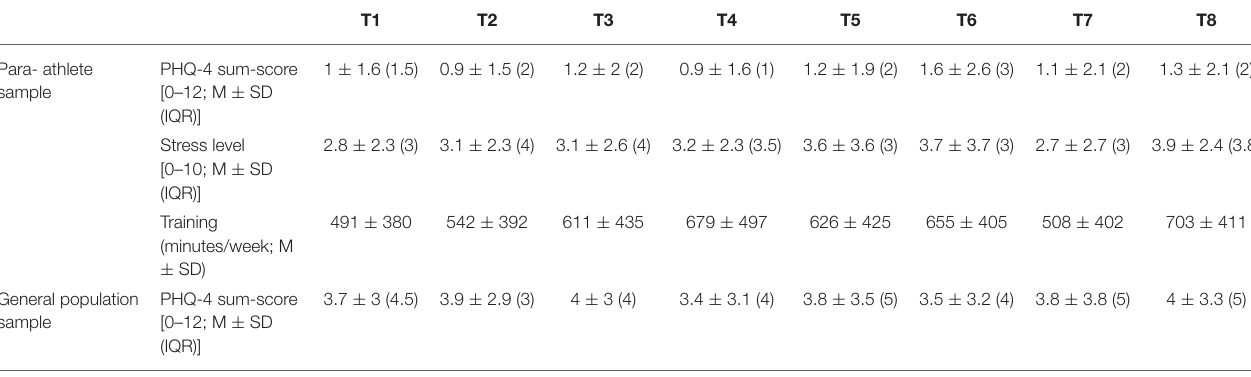
General population sample